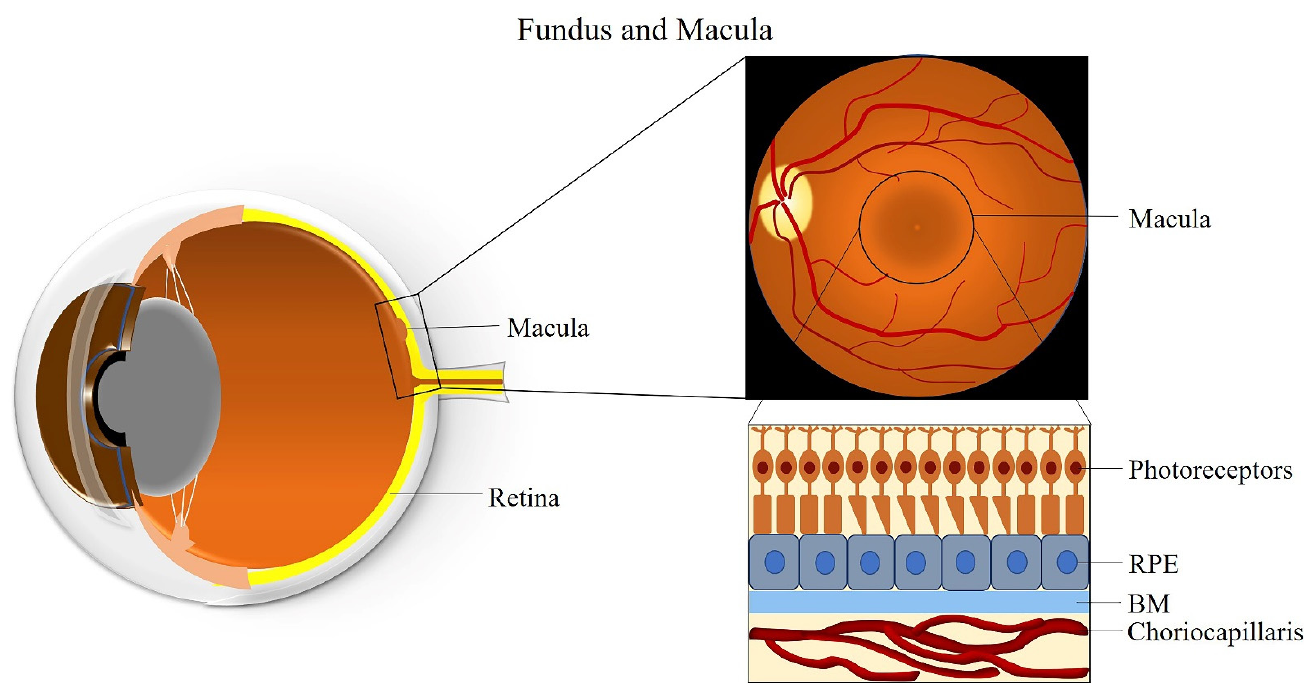
Figure 1. Anatomy of the fundus and macula. Abbreviations: RPE: retinal pigment epithelium; BM: Bruch’s membrane.